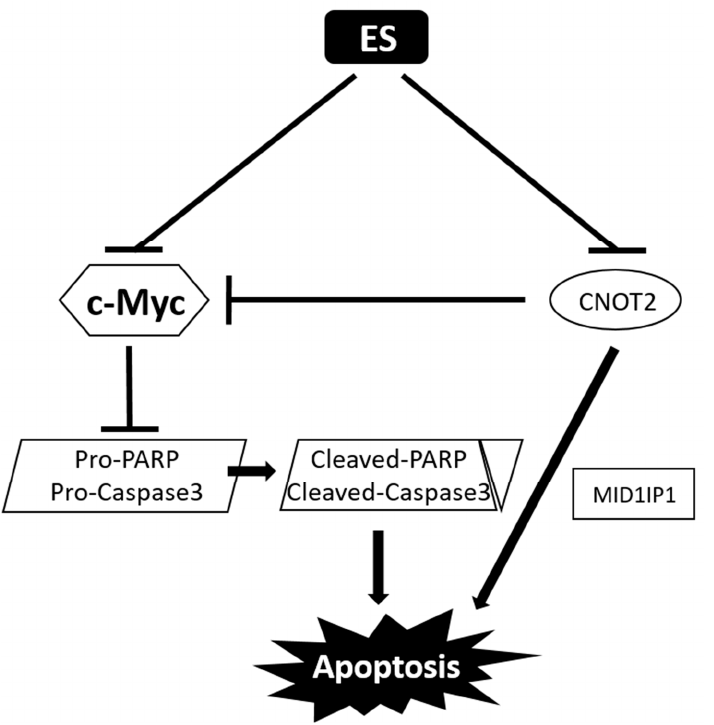
Figure 8. Mechanism scheme of ES in colon cancer cells. ES suppresses both c-Myc and CNOT2 in colon cancer cells. CNOT2 decreases c-Myc; pro-PARP and pro-Caspase3 are downregulated; and cleaved-PARP and cleaved-caspase3 are upregulated, leading to apoptosis. In addition, inhibition of CNOT2 induced apoptosis via MID1IP1.